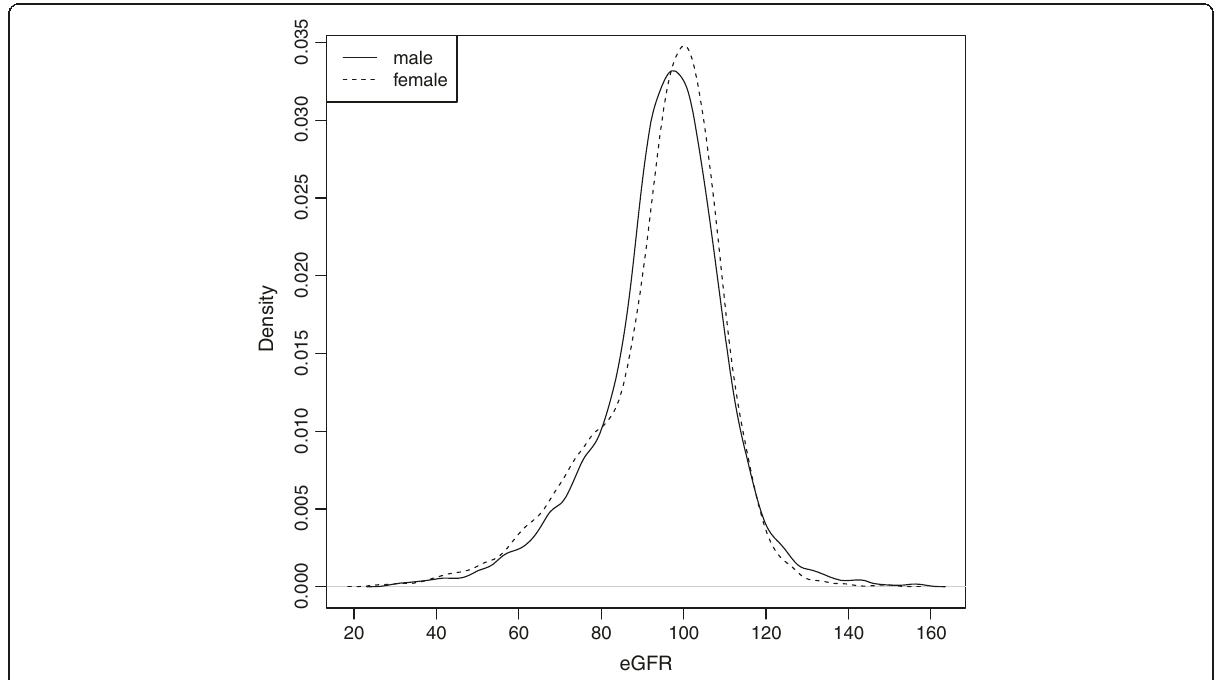
Figure 1 The density curves of eGFR. eGFR = estimated glomerular filtration rate, eGFR was in unit of ml/min/1.73 m 2